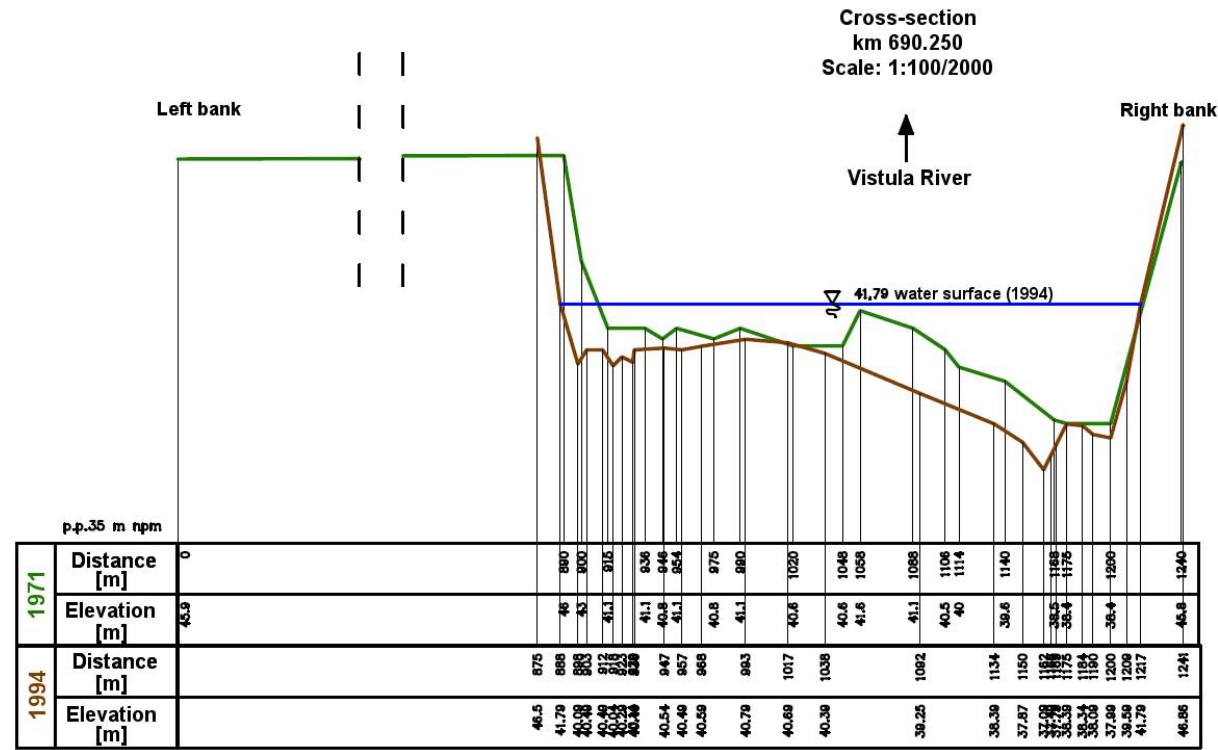
Fig. 1. Selected cross-section of Vistula River with marked bed profiles in years 1971 and 1994. Significant changes at the bed profiles are